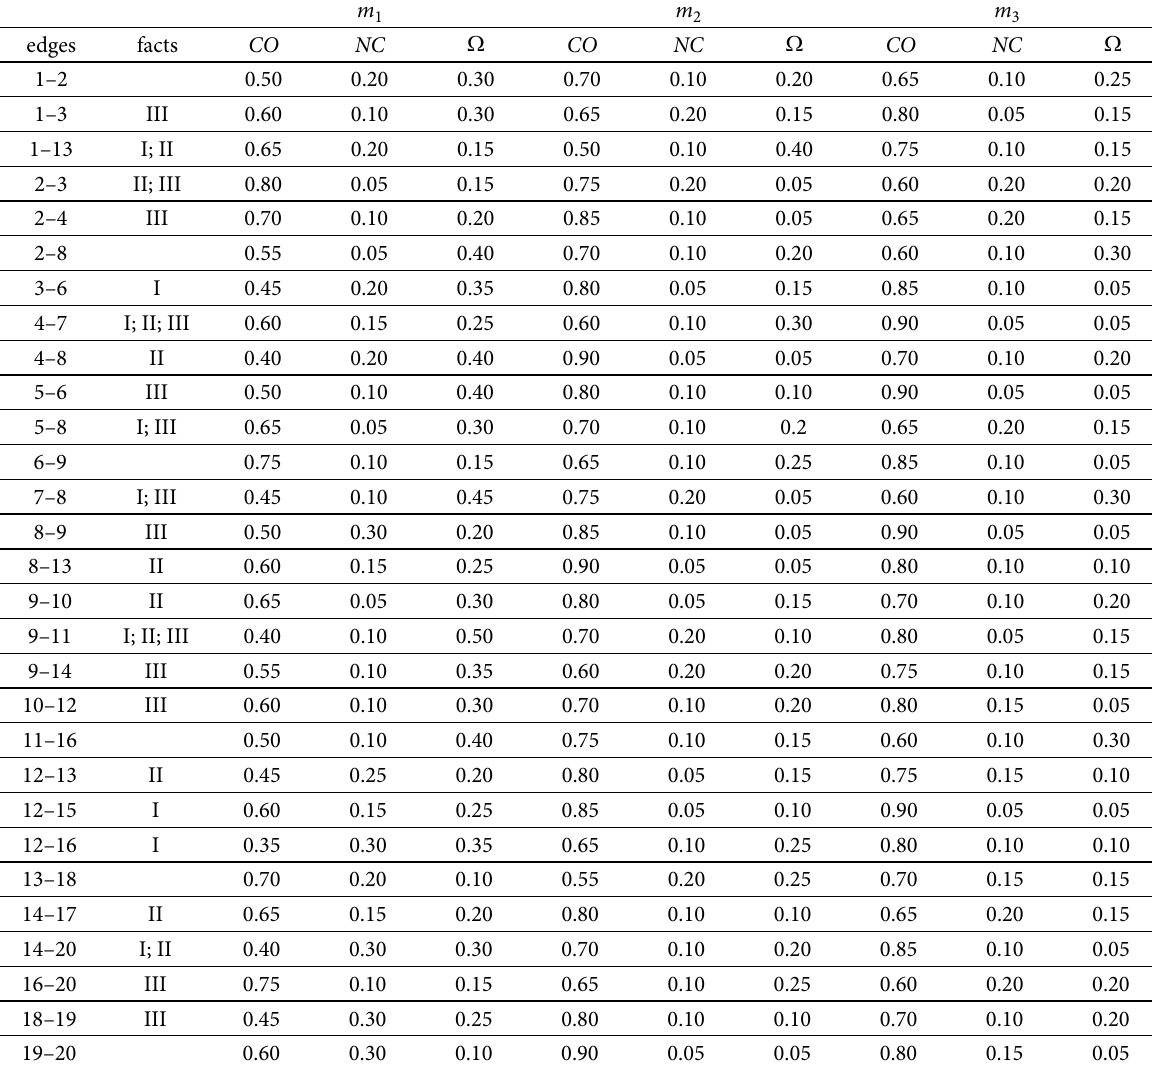
Table 3. BBA functions and real